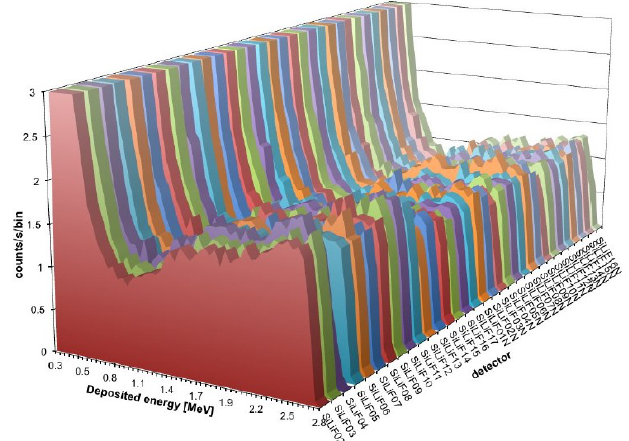
Fig. 5. The characteristic spectrum shape, measured for all the SiLiF detectors in the front position